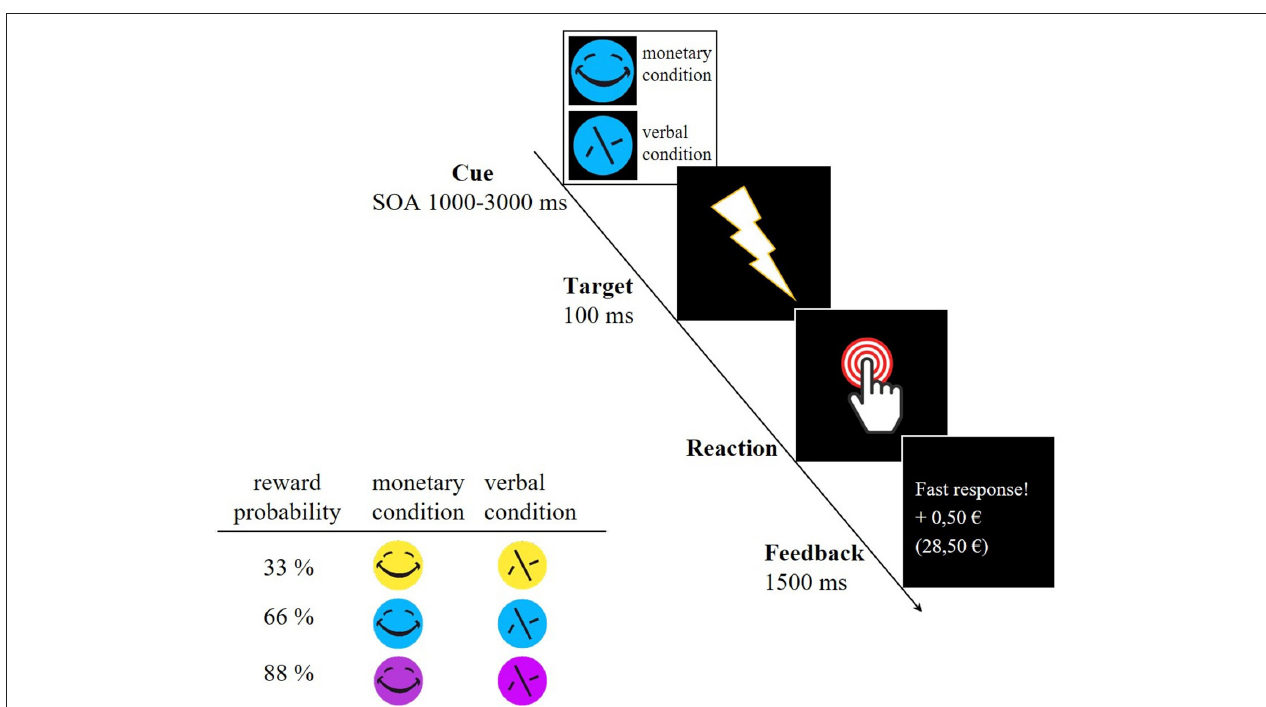
FIGURE 1 | Example trial of the MID task and reward probabilities indicated by differently colored cue stimuli. A smiley represented monetary trials whereas a scrambled face symbolized the control trial in which participants only received verbal feedback. SOA, Stimulus Onset Asynchrony.